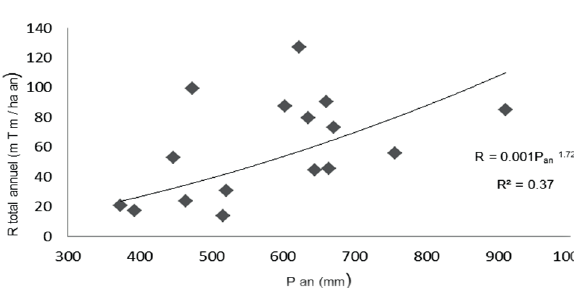
Fig. 5 Power model for relationship R=f(P an